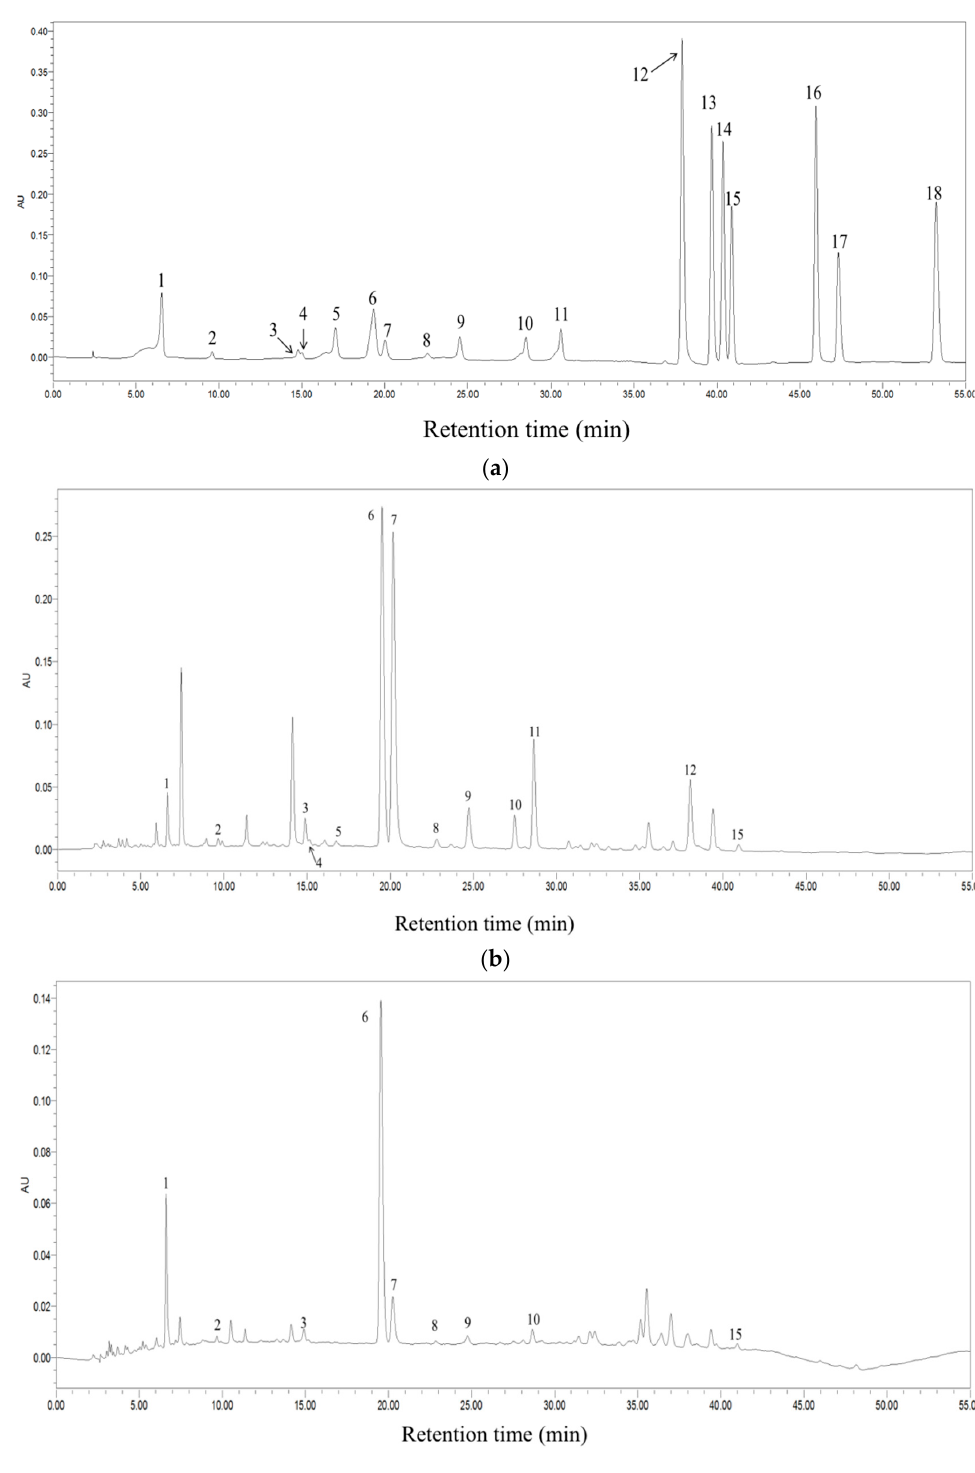
Figure 7. The HPLC chromatograms of the standard compounds ( a ), Fenggang zinc-selenium-enriched Tea ( b ), and Black Fu Brick Tea ( c ) under 254 nm. 1, gallic acid; 2, gallocatechin; 3, epigallocatechin; 4, catechin; 5, chlorogenic acid; 6, ca ff eine; 7, epigallocatechin gallate; 8, epicatechin; 9, gallocatechin gallate; 10, epicatechin gallate; 11, catechin gallate; 12, ellagic acid; 13, myricetin; 14, quercitrin; 15, astragalin; 16, quercetin; 17, theaflavin; 18,